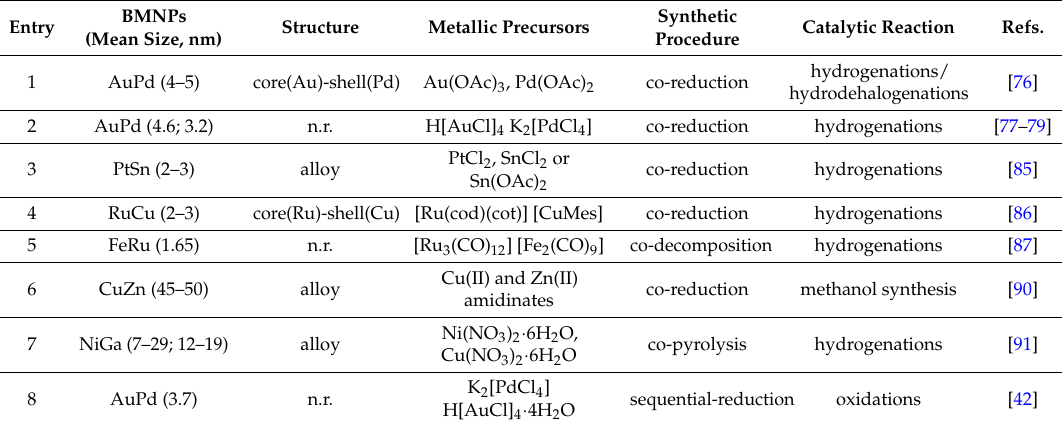
Table 3. Bimetallic nanoparticles in ionic liquids applied in catalysis.